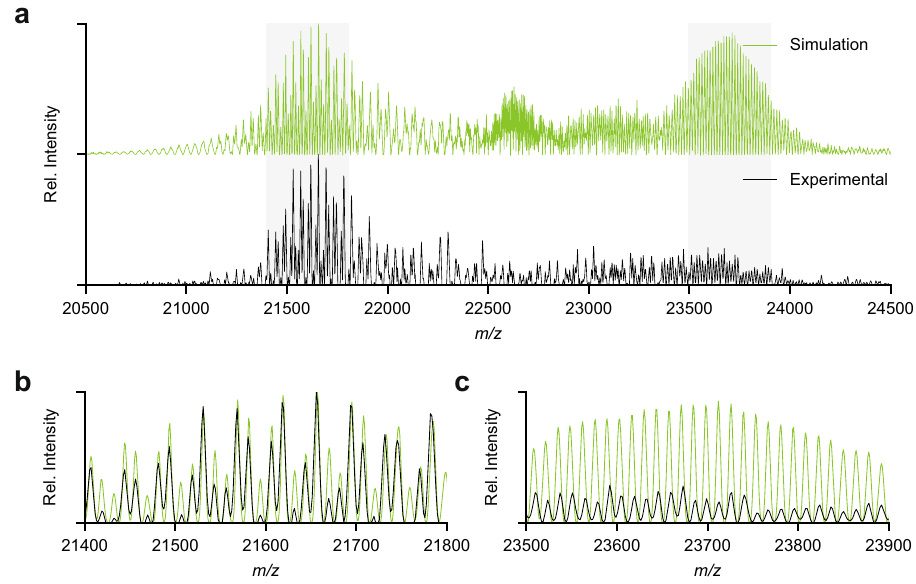
Fig. 6 Resolved ion fi ne structure in the native mass spectra for wild-type AAV9. a Baseline corrected simulation for AAV9, at a resolution corresponding to 128 ms transient time, with its experimental counterpart. b , c Overlay of resolved regions for the simulation with the experimental